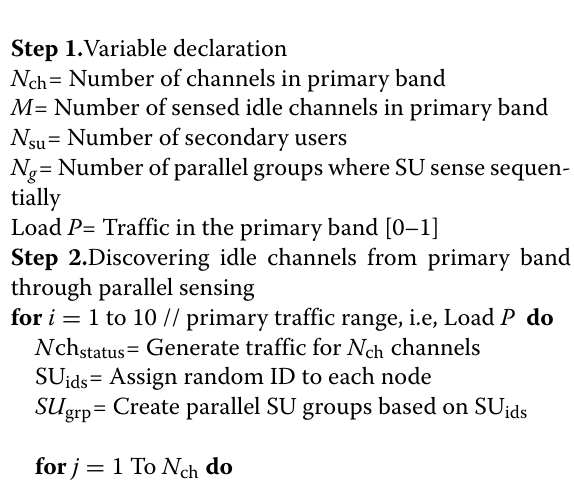
Algorithm 1 Parallel